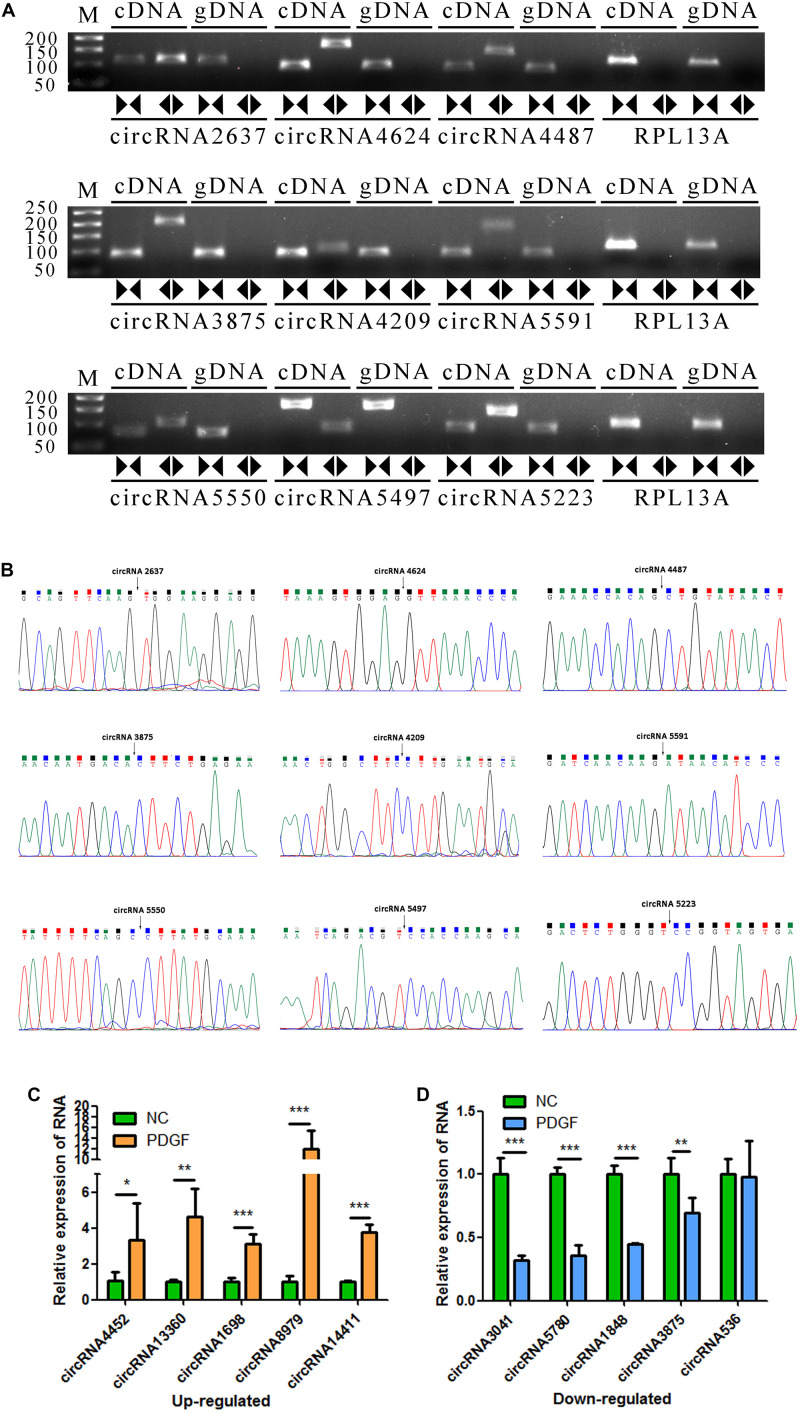
Validation of VSMC-enriched circRNAs. (A) Nine circRNAs were selected for validation experiments. RT-PCR with divergent (circular) and convergent (linear) primers was used to confirm the candidate circRNAs. Divergent (circular) primers (◀▶) successfully amplified a single fragment at the expected sizes from cDNA but not from genomic DNA (gDNA). Convergent (linear) primers (▶◀) could amplify from both cDNA and gDNA. (B) Sanger sequencing of the selected candidate circRNAs shows the back-splice junctions. (C,D) The relative expression levels of 10 DE circRNAs were determine by qRT-PCR. The data are presented as the mean ± SD, n = 3. *P <0.05, **P <0.01, and ***P <0.001.